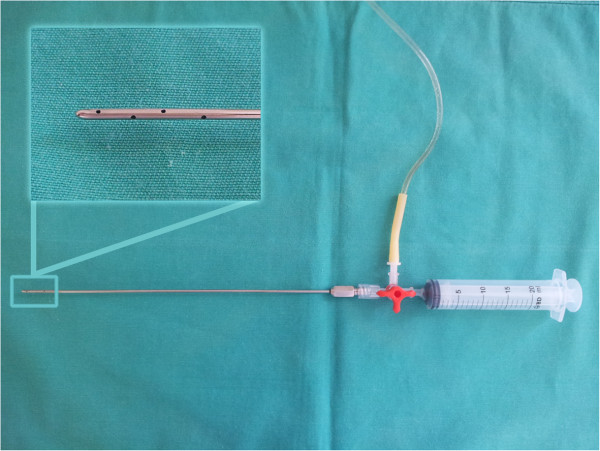
Closed circuit used to infiltrate the tumescent solution with the detail of the blunt infiltration cannula with side holes.